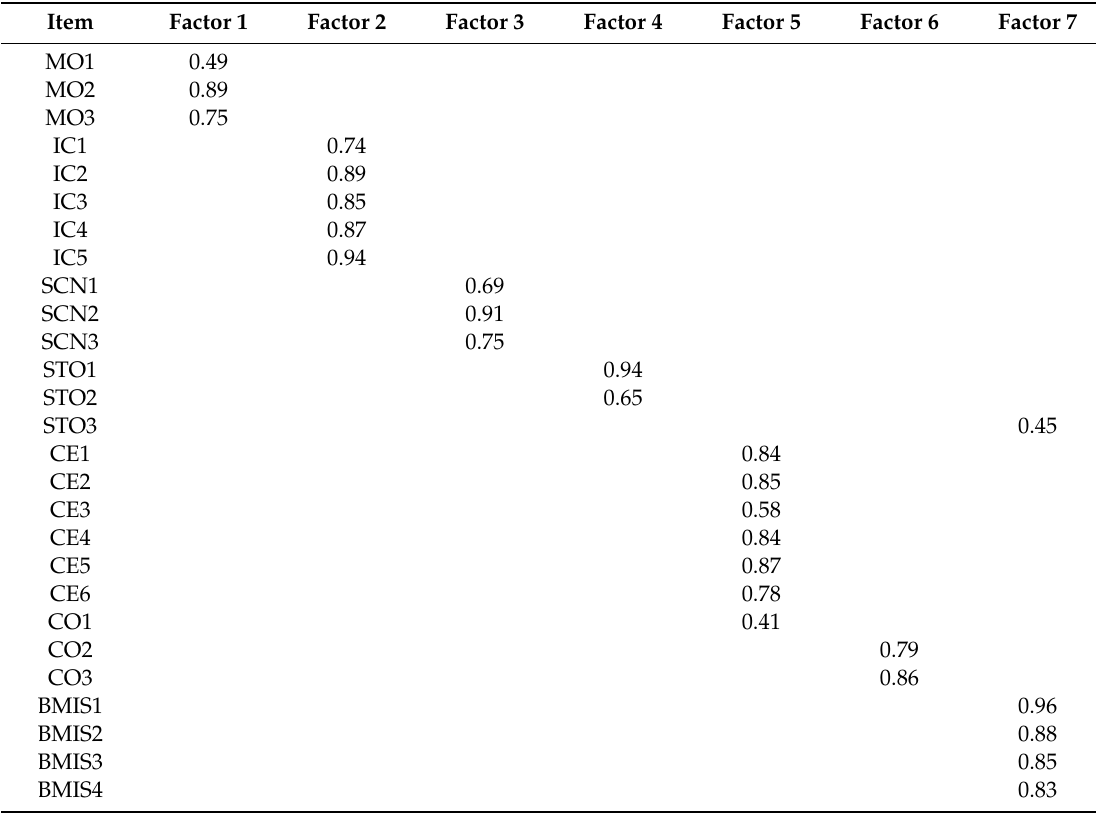
Table 1. Exploratory factor analysis for